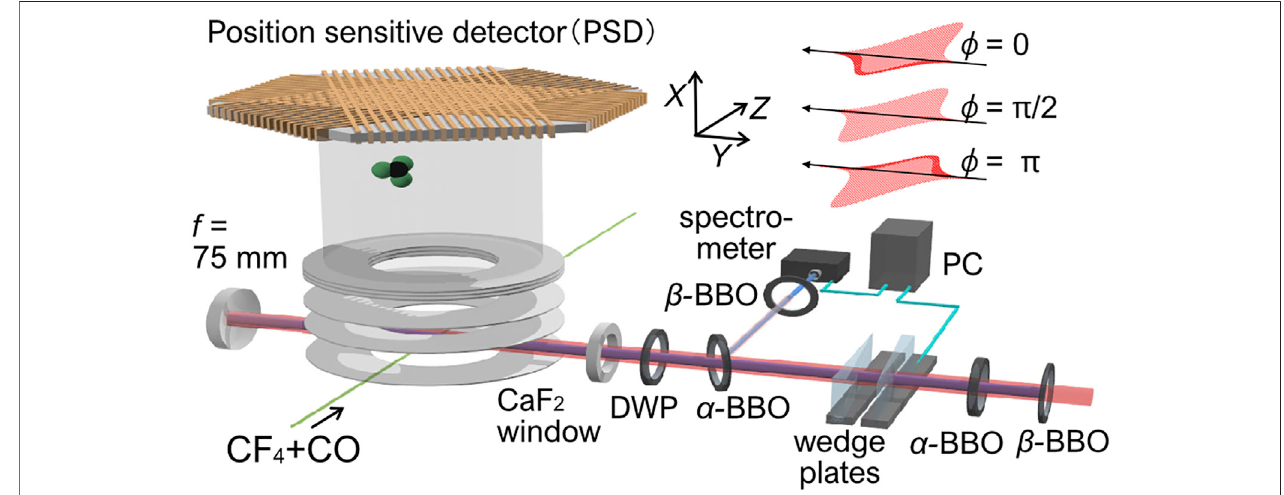
FIGURE 1 | Schematic ofthe experimental setup.The output from aTi: Sapphire regenerative laser ampli fi er system (800 nm, 1 kHz, 50 fs) was introduced to a β - BBO crystal (type-I) to generate a second-harmonic pulse (400 nm). The time delay between the fundamental ( ω ) and the second harmonics (2 ω ) pulse was compensated by two birefringent α -BBO crystals. The two-color relative phase was stabilized by a pair of fused-silica wedge plates controlled by the active feedback lockingtothe2 ω -2 ω interferencespectrum.Thepolarizationofthefundamentalandthesecondharmonicpulsewassetparallelbyadual-wavelengthplate(DWP). For the phase calibration, CO gas is mixed with the sample gas of CF 4 .